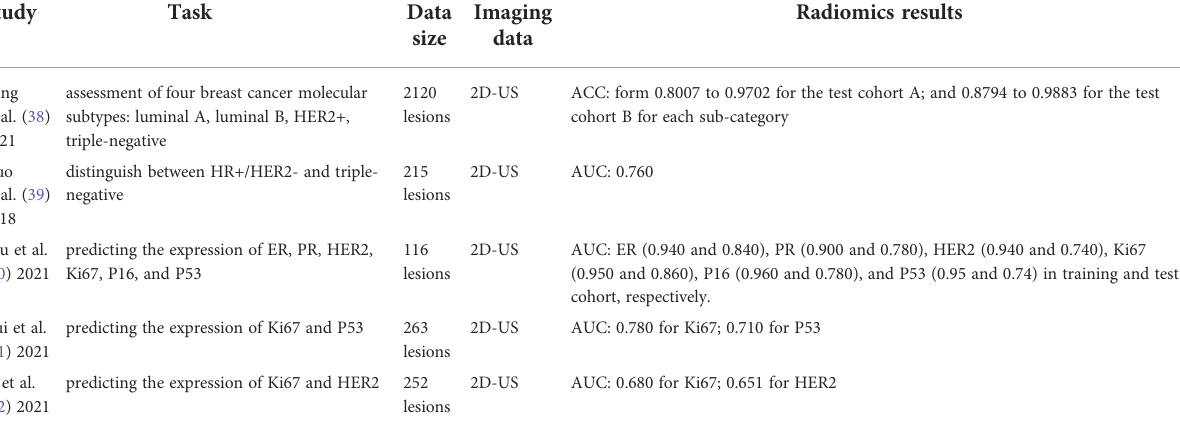
TABLE 2 Summary of ultrasound radiomics studies in classifying breast cancer